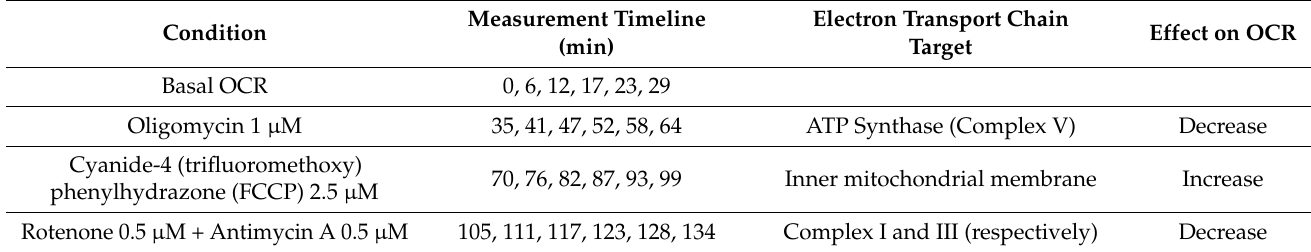
Table 4. Seahorse treatment